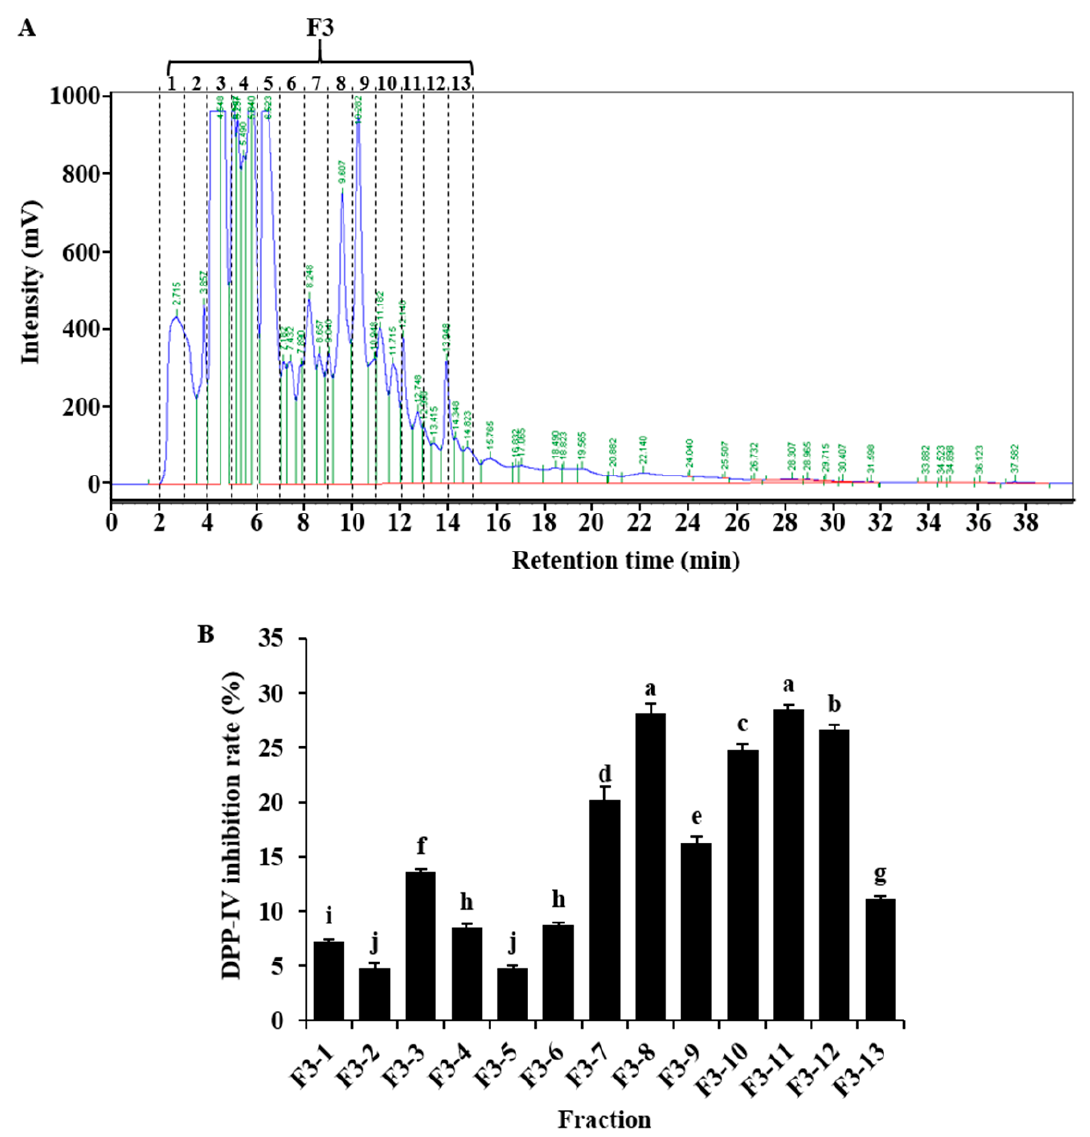
Figure 3. High-performance liquid chromatography profile of F3 fraction from Sephadex G-25 gel filtration chromatography ( A ) and dipeptidyl peptidase-IV (DPP-IV) inhibitory activity of fractions ( B ). The DPP-IV inhibition rate was determined using sample of 0.024 mg/mL (final assay concentration). Values are expressed as means ± SD of 3 independent determinations. Different letters indicate significant differences ( p < 0.05).